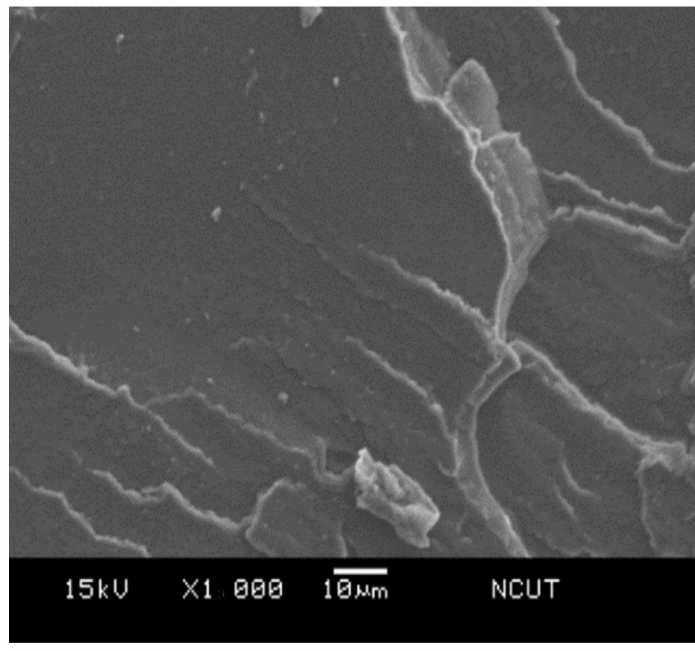
Figure 17. SEM micrograph of the fractured surface on NPST